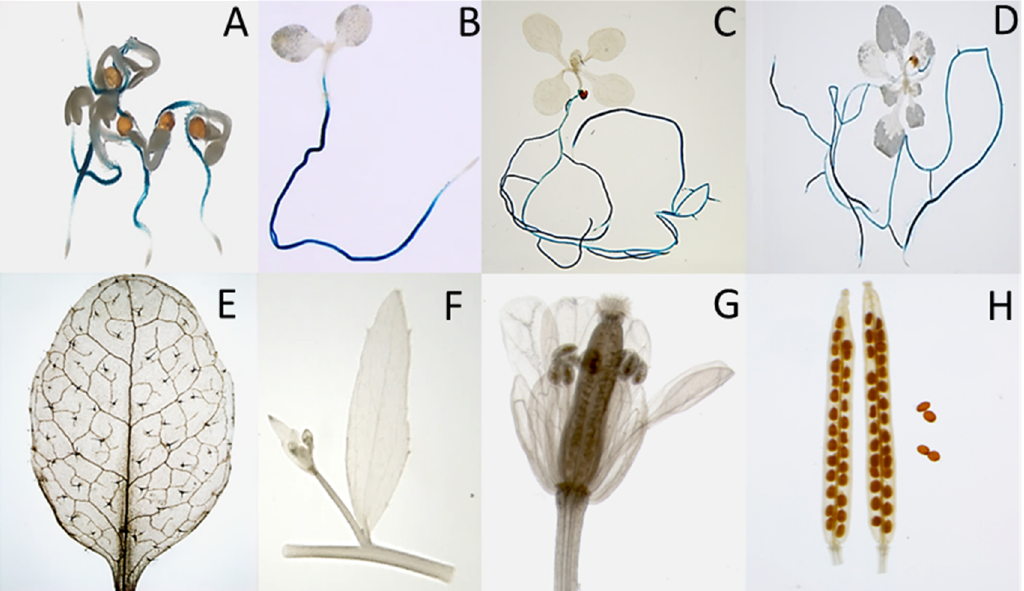
Figure 6. GUS expression in the At3g59930::GUS transgenic line. ( A – D ), seedlings grown on MS medium for 1, 5, 10 and 14 days. GUS expression is only visible in roots but not root tip, cotyledons or leaves. ( E – H ), plants grown on soil in long day. No GUS expression was found in rosette leaves ( E ), stem and cauline leaves ( F ), flowers ( G ) or siliques and seeds ( H ).